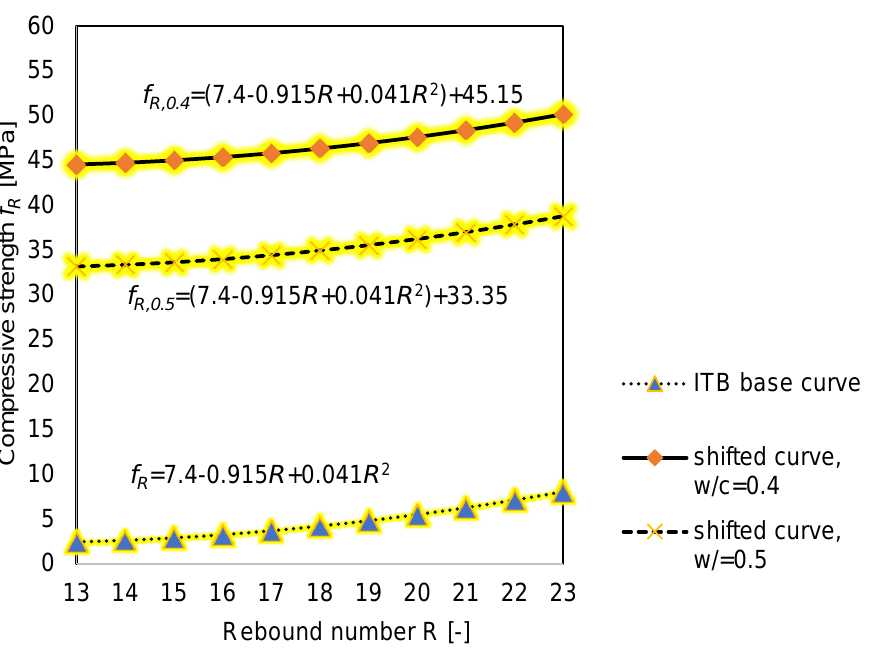
Figure 7. Curve dependence of concrete strength on the rebound number f R -R. Table 4. Estimated strength of cementitious materials impregnated using hydrophobic agents based on near-surface hardness